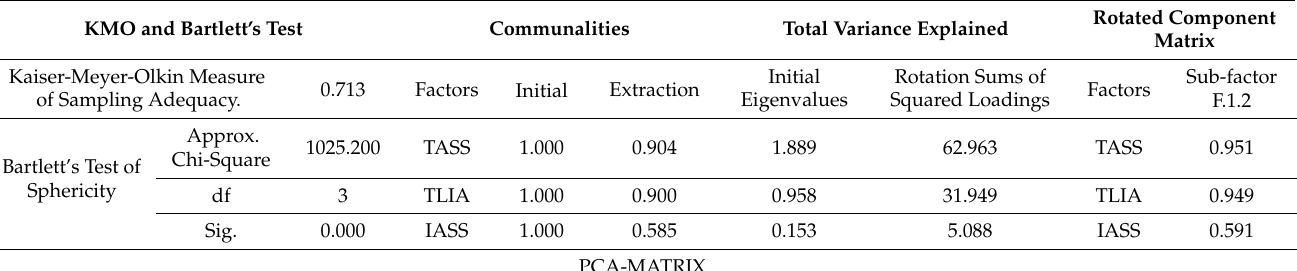
Table 7. Results of the second sub-factor (F1.2) of sustainable profit through factor analysis. KMO and Bartlett’s Test Communalities Total Variance Explained